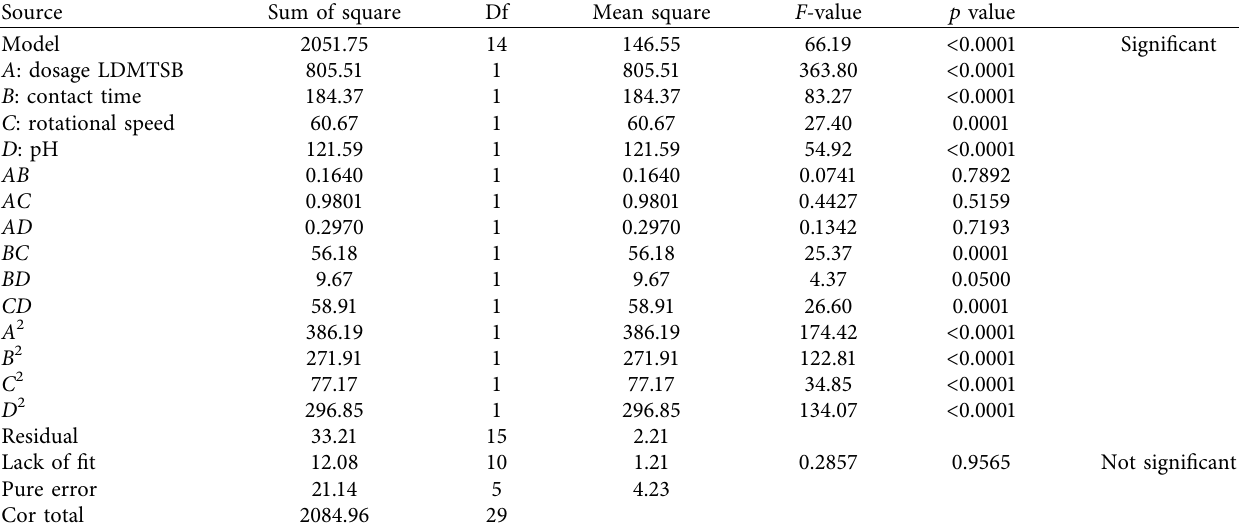
Table 4: Analysis of variance (ANOVA)